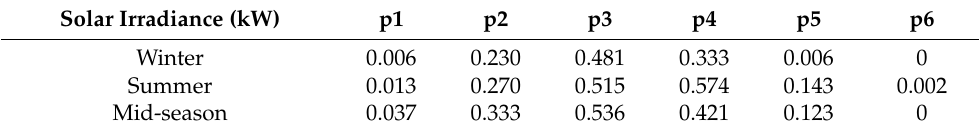
Table 1. Solar irradiance [24].